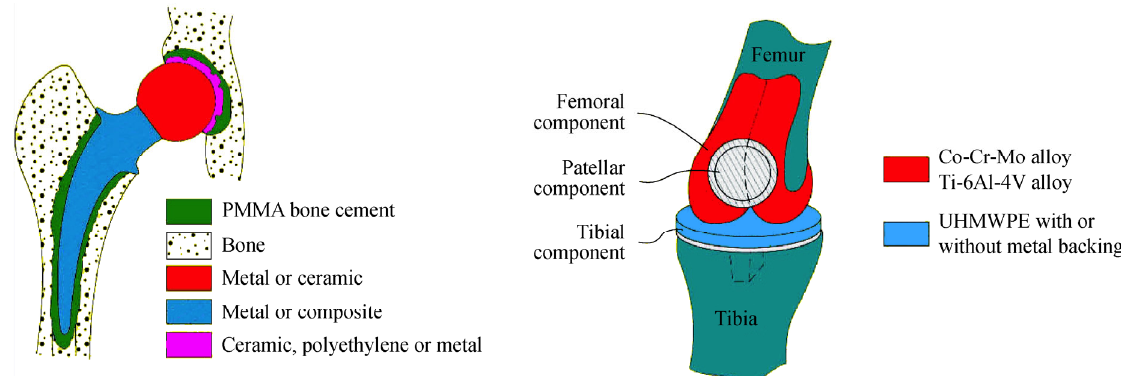
Fig. 7 Schematic diagrams of hip and knee implants (adapted from Ref.